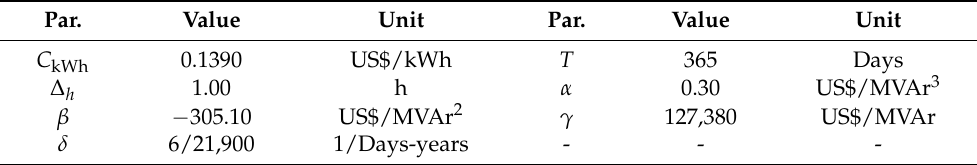
Table 4. Parameters for evaluating the installation costs of the D-STATCOMs. Par.